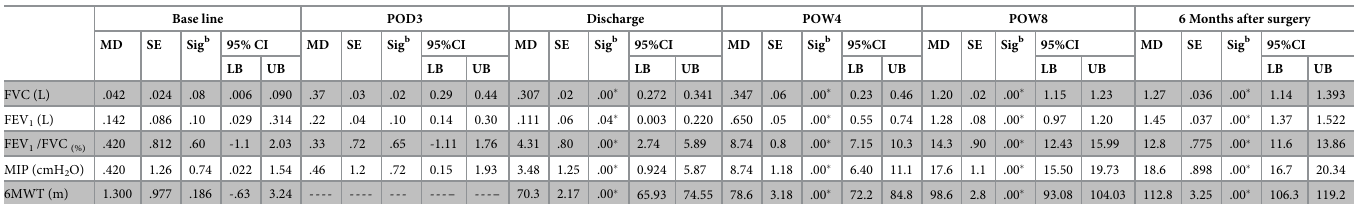
Table 4. Pairwise comparison between study (n = 50) and control groups (n = 50) over time. Baseline